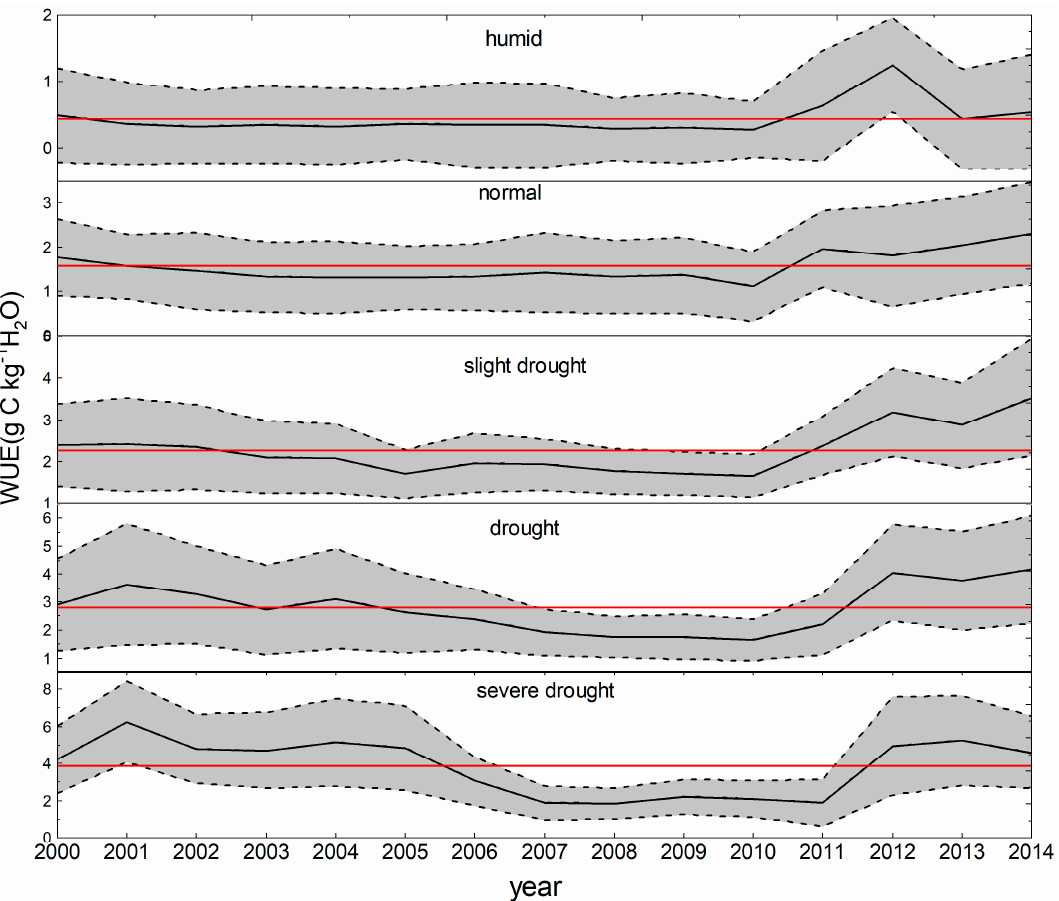
Figure 3. The WUE changes in different drought classifications from 2000 to 2014; the red line is the mean multiyear WUE, and the grayscale represents the standard deviation of WUE.